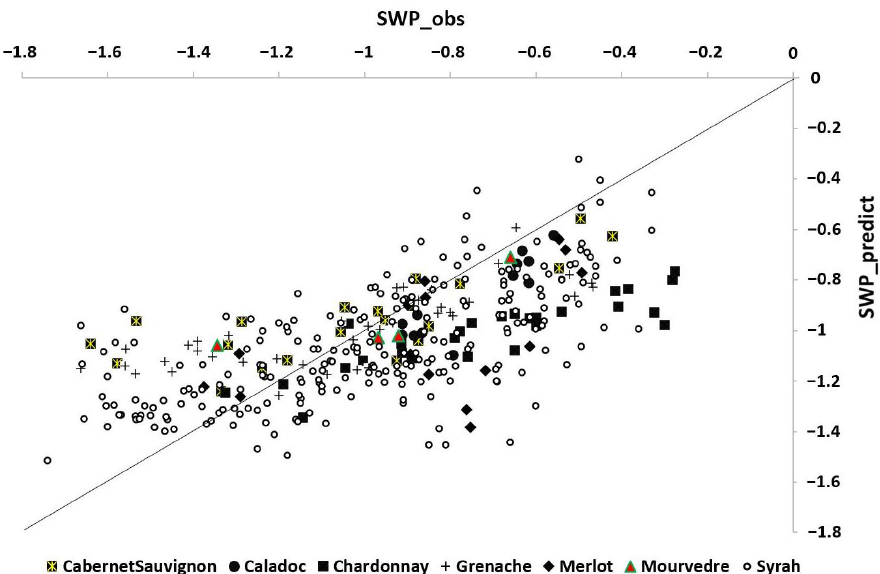
Figure 12. Data distribution according to grapes variety.